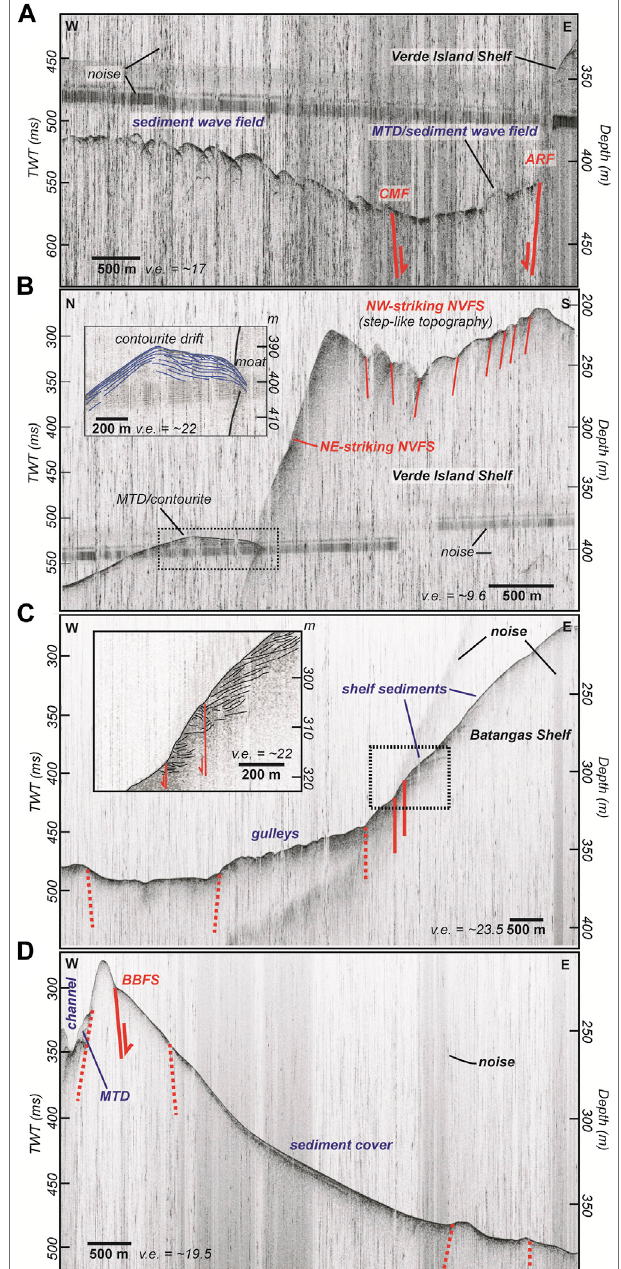
FIGURE 8 | Subbottom pro fi les in (A) West Verde Basin, (B) Northern Verde Region, and (C,D) Batangas Bay. See text for discussion. Depth was calculated using a velocity of 1500 m/s. Locations of the pro fi les are in Figure 2 and Figure 6 . ARF, Aglubang River Fault; CMF, Central Mindoro Fault; MTD, Mass Transport Deposit; NVFS, North Verde Fault System; BBFS, Batangas Bay Fault System.